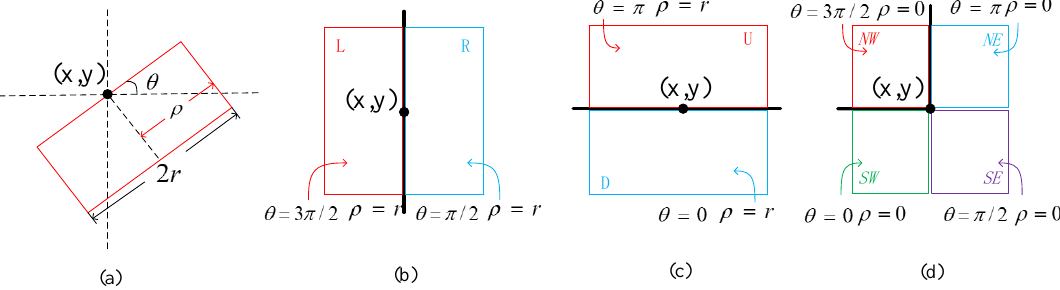
Figure 2. The definition of the side window. r is the radius of the window. ( a ) Definition of side window in continuous case. ( b ) The left (red rectangle) and right (blue rectangle) side windows. ( c ) The up (red rectangle) and down (blue rectangle) side windows. ( d ) The northwest (red rectangle), northeast (blue rectangle), southwest (green rectangle) and southeast (purple rectangle) side